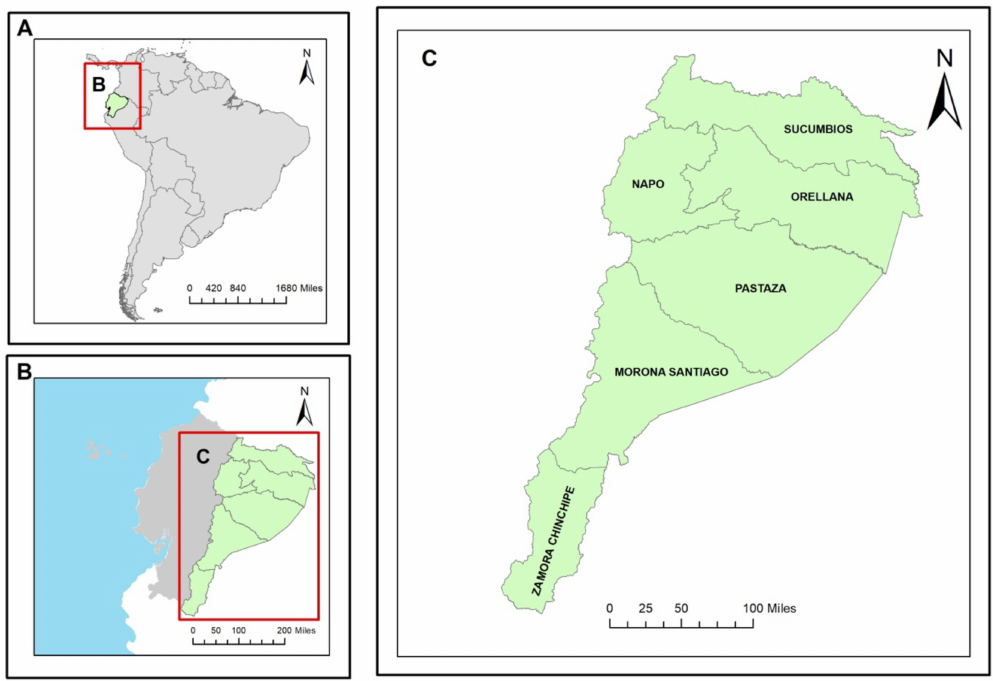
Figure 1. Study area : ( A ) Geographical location of Ecuador; ( B ) Amazon region of Ecuador; ( C ) provinces belonging to the Amazon